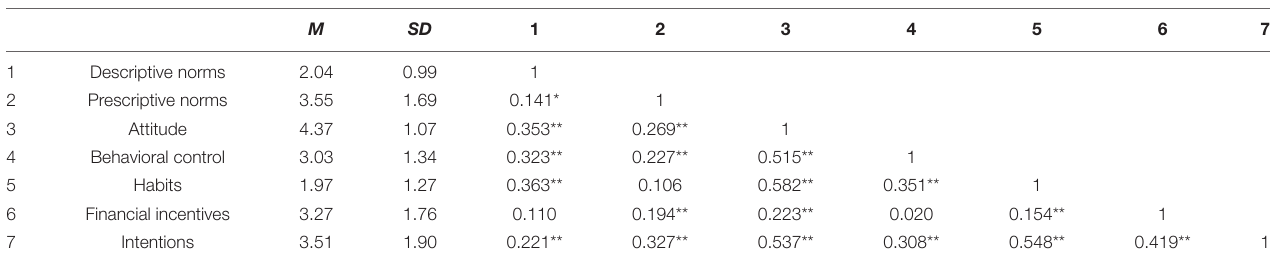
TABLE 1 | Means, standard deviations, regression coefficients, and correlations.